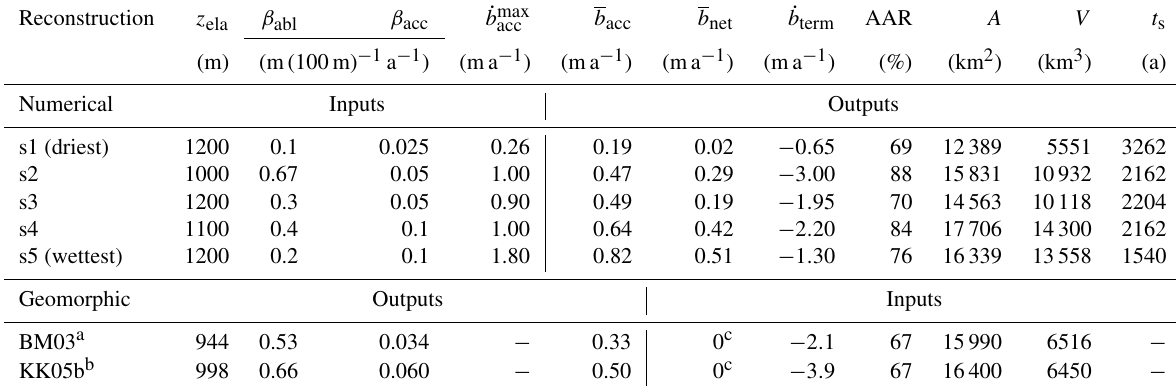
Table 2. Summary of numerical (this study) and selected geomorphic reconstructions. z ela is the elevation of the equilibrium line. β abl and β acc are the ablation and accumulation mass balance gradients, respectively. ˙ b max acc is the maximum accumulation rate. b acc is the average accumulation rate. b net is the glacier net mass balance. ˙ b term is the ablation rate at the terminus. AAR is the accumulation area ratio. A is the glacier area and V its volume. t s is the simulated time. Numerical simulations s1 through s5 are ranked from driest to wettest based on the value of the average accumulation rate, b acc . Initial conditions for the ice surface are the geomorphic reconstruction of Benz-Meier (2003) for s1, a simulation with β acc = 0 . 1m ( 100m ) − 1 a − 1 , β abl = 0 . 2m ( 100m ) − 1 a − 1 , and z ELA = 1200m that ran for 440 years using the Benz- Meier (2003) reconstruction as the initial condition for s2, and a simulation with β acc = 0 . 05m ( 100m ) − 1 a − 1 , β abl = 0 . 2m ( 100m ) − 1 a − 1 , and z ELA = 900m that ran for 907 years using Benz-Meier (2003) as the initial condition for s3, s4, and